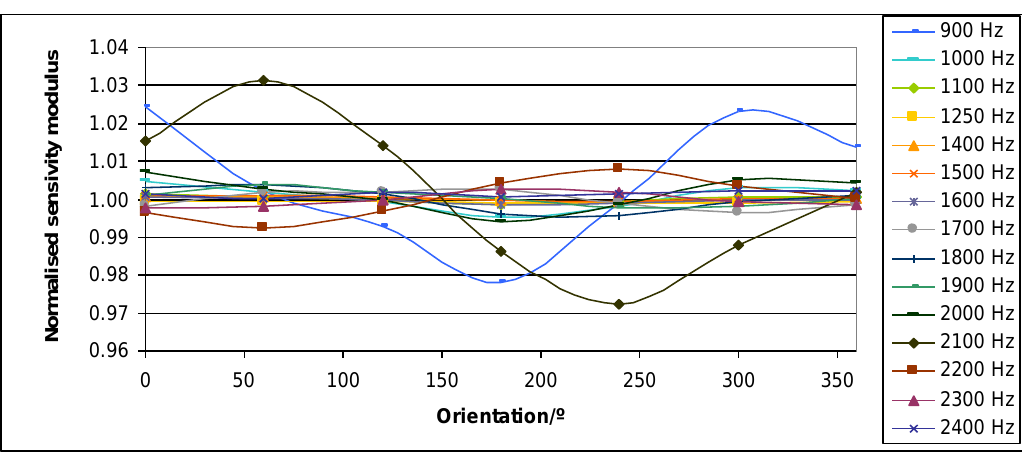
Figure 7. Each curve represents the modulus of sensitivity divided by the mean value for a different excitation frequency versus the different orientations of the laser vibrometer beam measuring location (minimum radius) for the Interface 1610 sensor (2 kg loading